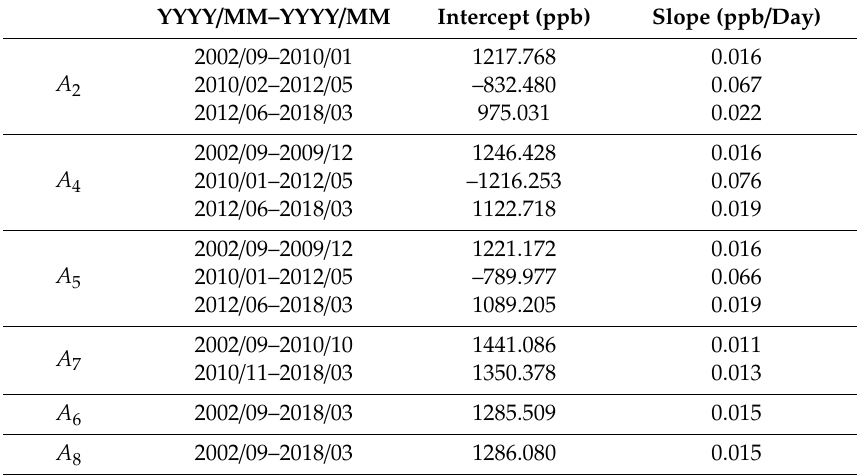
Table 6. Intercept and slope values of each segment of T ( t ) of A 2 , A 4 , A 5 , A 6 , A 7 , and A 8 . YYYY / MM–YYYY /